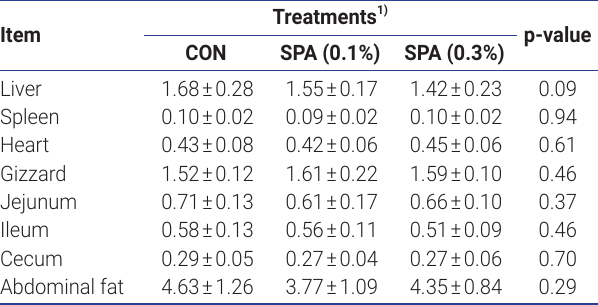
Table 7. Effect of supplementary SPA on relative weights of organs in laying hens